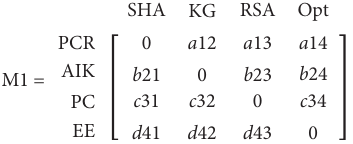
Figure 3: Mathematical analysis with respect to